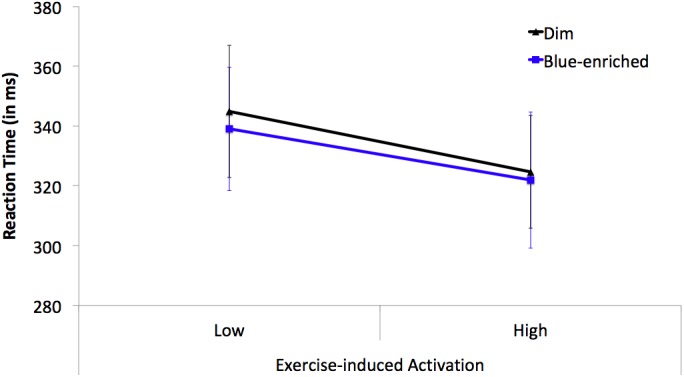
Mean reaction times (RTs) on the PVT as a function of Lighting (black line triangle marker: dim light; blue line square marker: blue-enriched light) and Exercise-induced Activation (low vs. high arousal). Vertical bars represent the standard error of the mean.